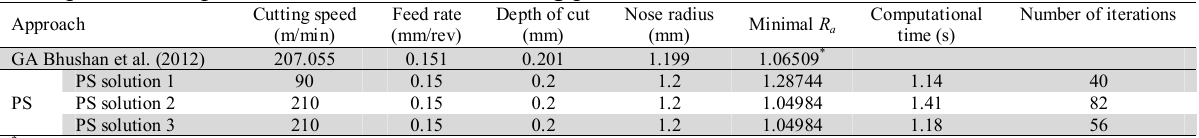
Comparison of optimization solutions for turning process Cutting speed Approach